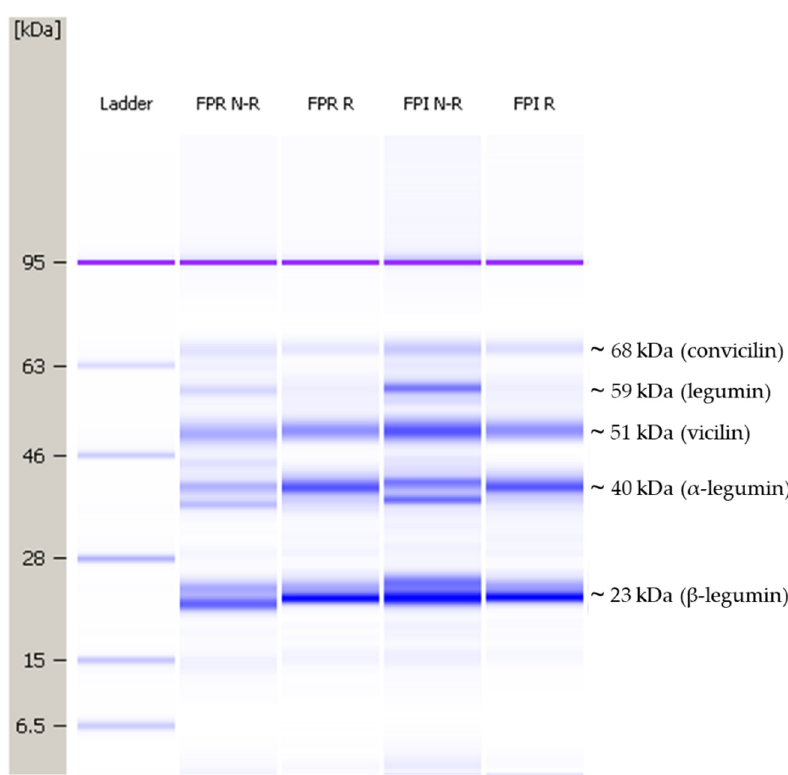
Figure 1. Representative protein profiles for faba bean protein-rich flour (FPR) and faba bean protein isolate (FPI) under non-reducing and reducing conditions, in the range of 5–80 kDa. N-R: non-